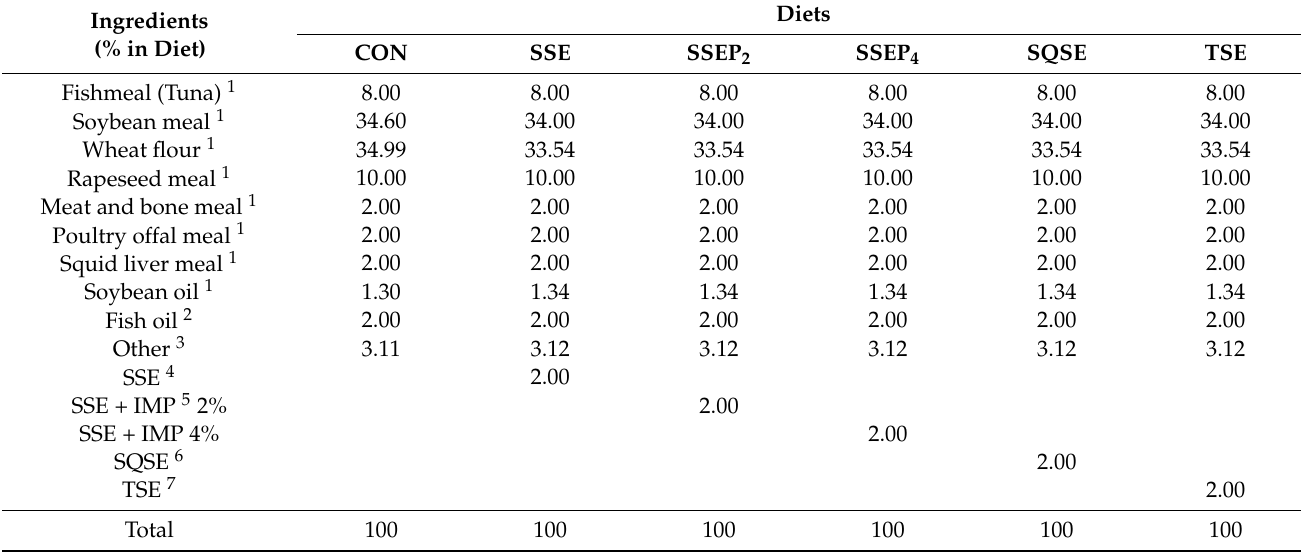
Table 1. Formulations and proximate compositions of six experimental diets (percentages of dry matter basis).